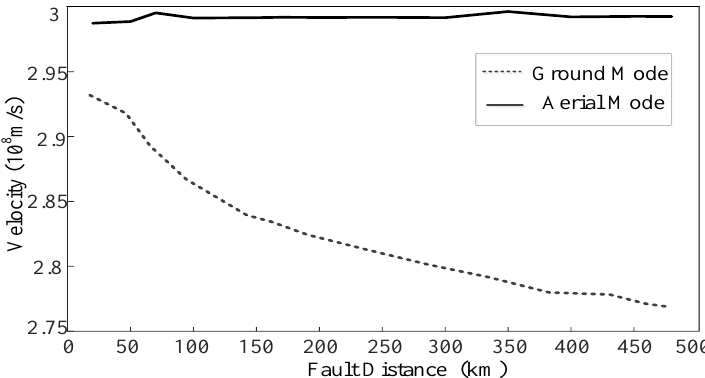
Figure 4. The tendency of ground-mode velocity and aerial-mode velocity.